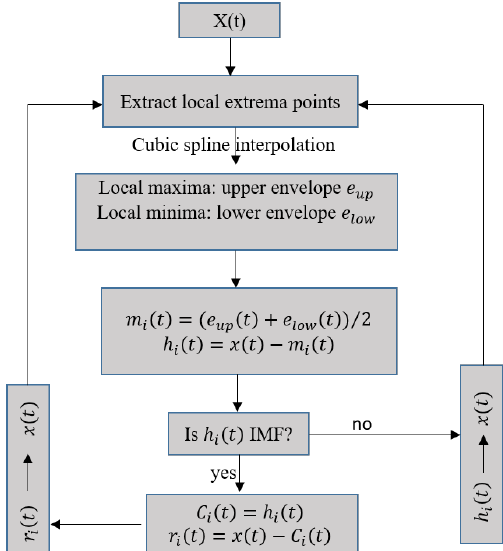
Figure 4. Flowchart of the sifting process for the empirical mode decomposition (EMD) algorithm.